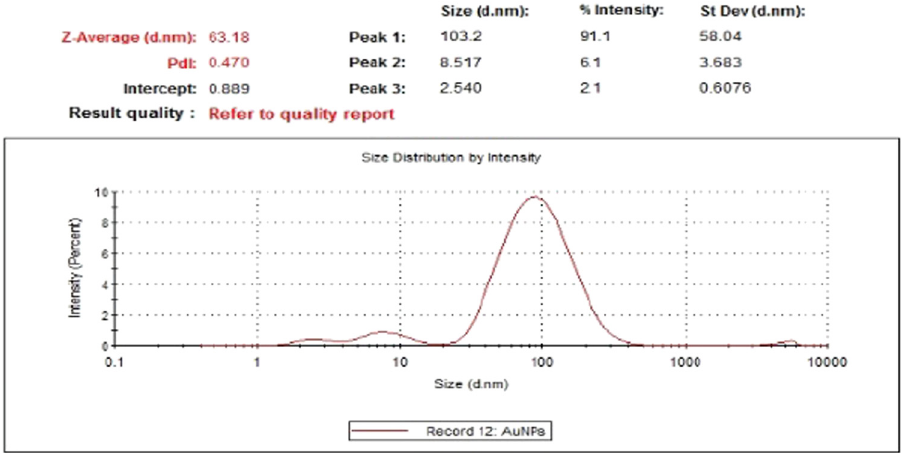
Figure 5: DLS graph showing size distribution, mean size, and standard deviation of SE -